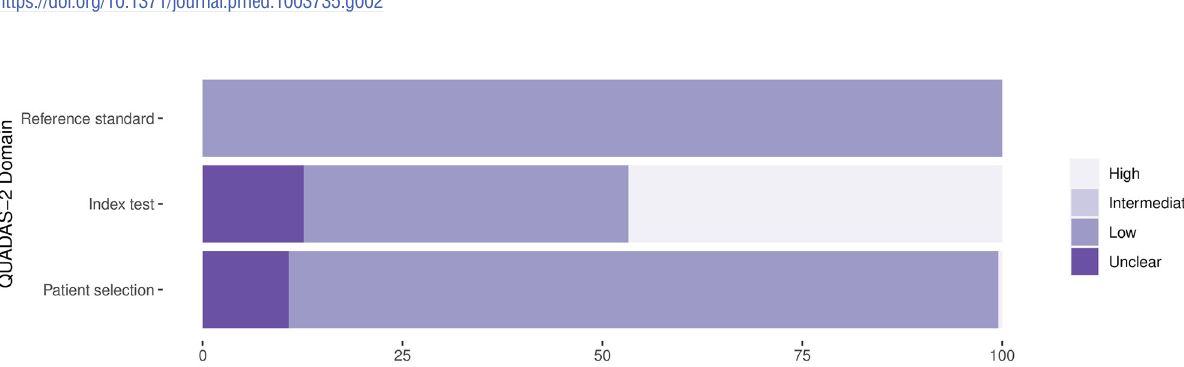
Fig 3. Methodological quality of the clinical accuracy studies: Applicability. Proportion of studies with low, intermediate, high, or unclear concerns regarding applicability (percent).